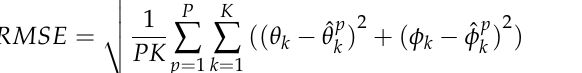
Figure 6. The scatter image of DOAs with E ‐ MUSIC.